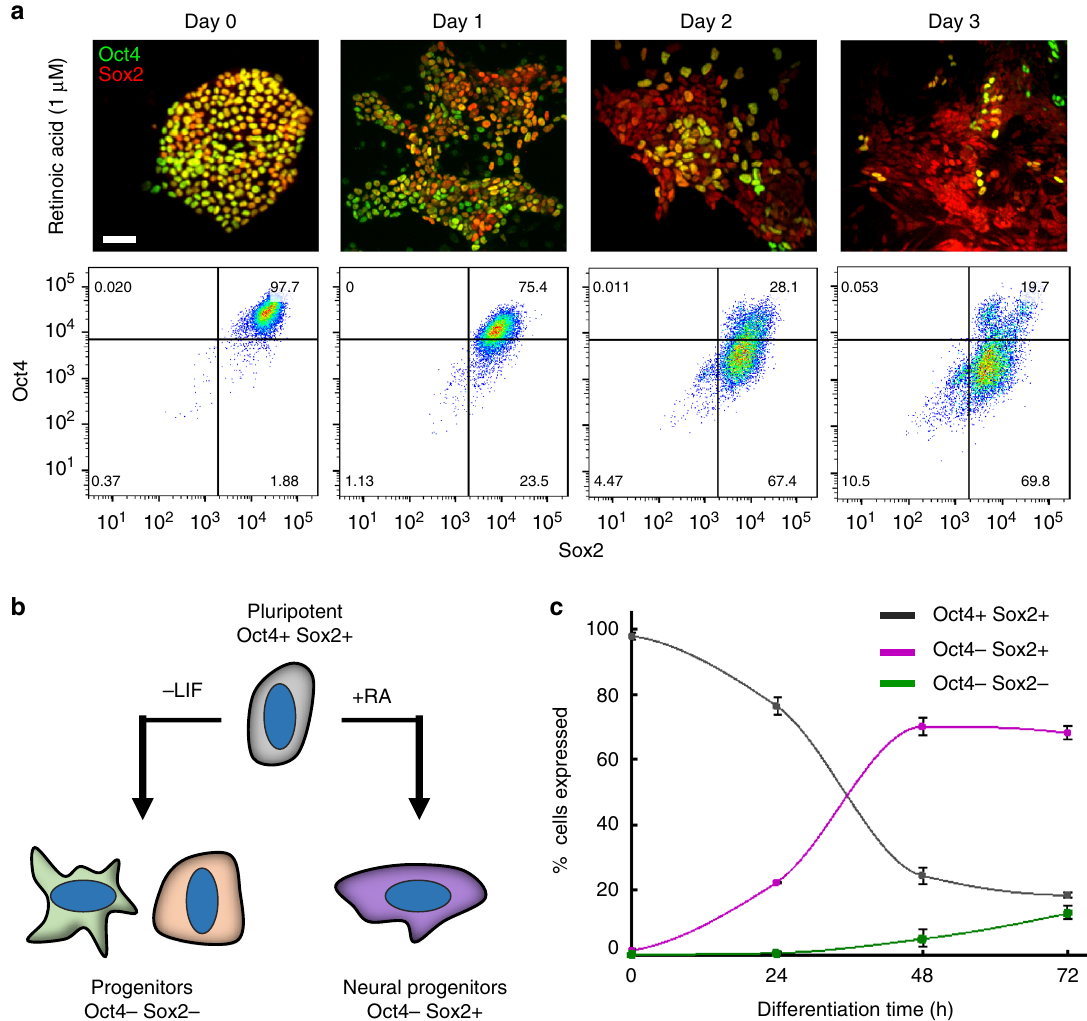
Fig. 1 Loss of Oct4 and maintenance of Sox2 expression during retinoic acid – induced differentiation. Oct4 expression begins to decline after 24-hour exposure to retinoic acid (1 μ M), with the main transition to an Oct4- state occurring between 24 and 48 h of RA treatment. After 72 h, ~ 70% of the population retain an Oct4-Sox2 + phenotype ( a , c ). A schematic depicting the change in gene expression in ESC populations towards the predominant progenitor state during two differentiation protocols: LIF-withdrawal in serum-containing media and retinoic acid addition ( b ). Quanti fi cation of fl ow cytometry data in a demonstrates the maintenance of the Oct4-Sox2 + state between 48 and 72 h of RA treatment ( c ), n = 9 (three biological replicates, three technical replicates for each biological replicate). Scale bar: 50